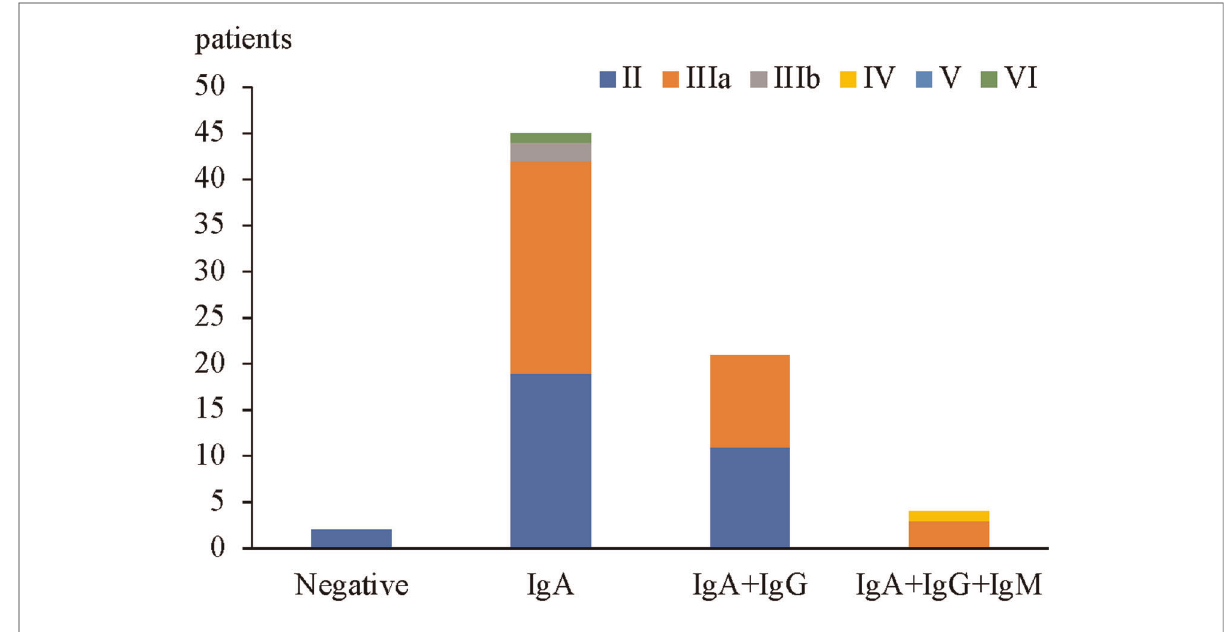
FIGURE 3 Renal pathological grades for different types of immunoglobulin deposition.